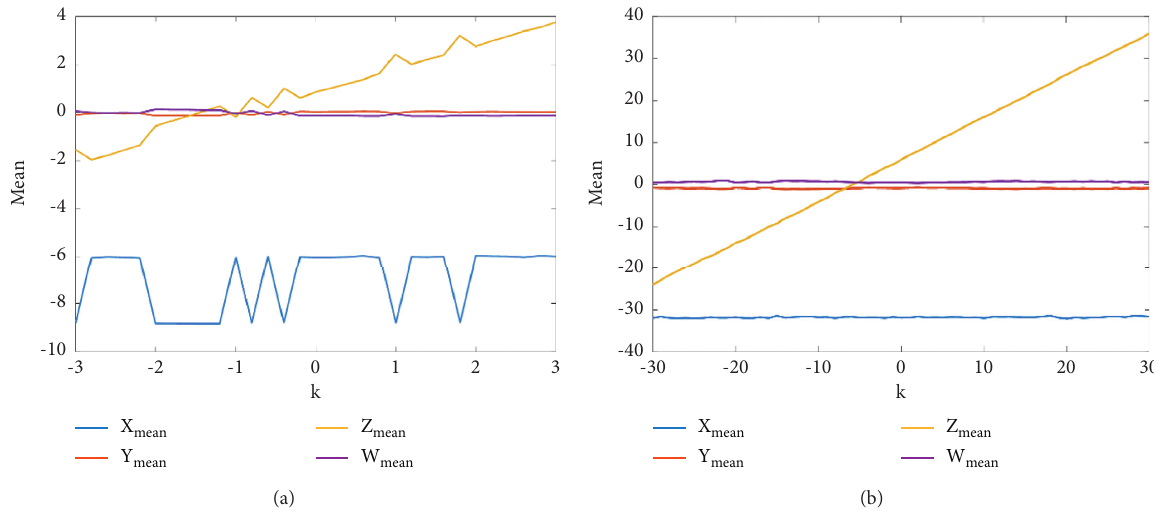
Figure 7: (a) and (b) the state variables’ average in systems (1) and (2). (a) The average of variable z does not precisely increase linearly when does not remain constant. However, in system (2), the linear increase of Z the control parameter k increases. Also, X mean